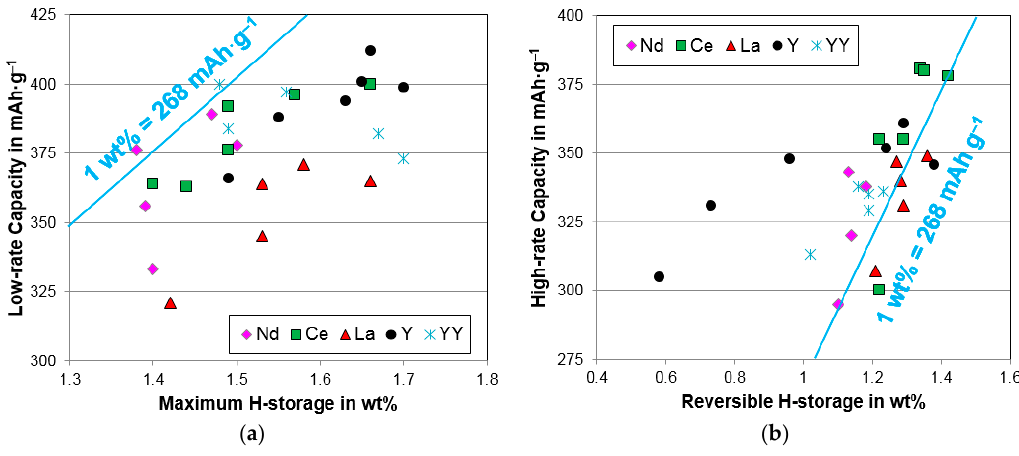
Figure 12. Comparisons of the electrochemical discharge capacities and gaseous phase H ‐ storages of the RE ‐ containing MH alloys by plotting: ( a ) low ‐ rate discharge capacity vs. maximum H ‐ storage capacity; and ( b ) high ‐ rate discharge capacity vs. reversible H ‐ storage capacity. Data set YY is from a previous study on the combination of Y ‐ addition and stoichiometry in the AB 2 MH alloys [8].